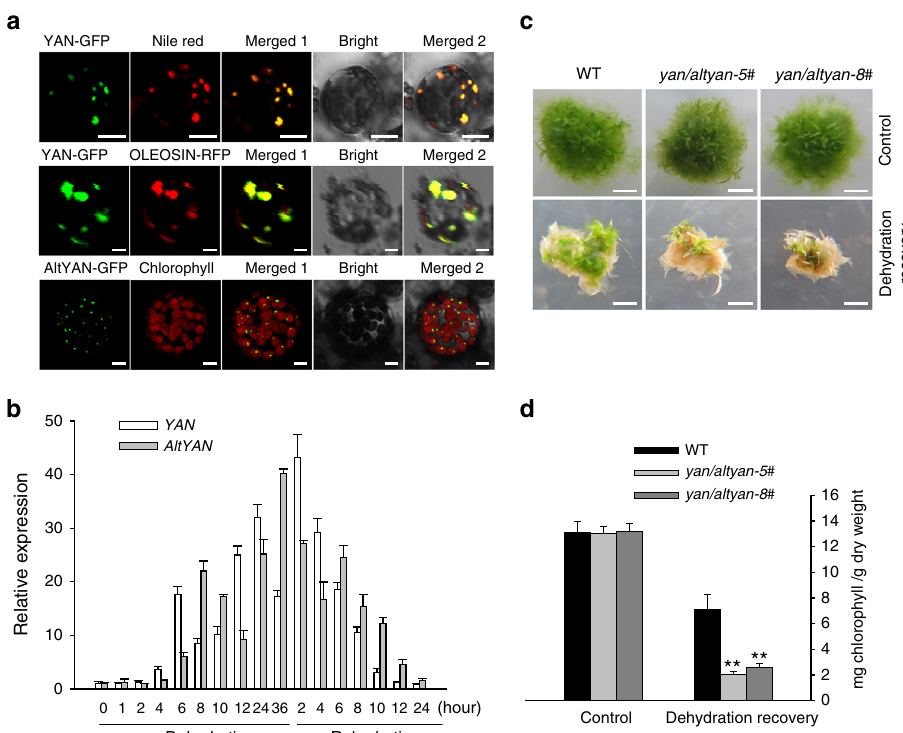
Fig. 2 Protein subcellular localization and recovery of P. patens clones after dehydration treatments. a YAN is localized in oil bodies as indicated by the green fl uorescence of YAN-GFP merged with Nile red and OLEOSIN-RFP (red), respectively. AltYAN-GFP is localized in chloroplasts as shown by the merged green fl uorescence of AltYAN-GFP with chlorophyll auto- fl uorescence (red). Scale bar = 4 μ m. b Expression pro fi le of YAN/AltYAN under dehydration and rehydration. Results represent means and standard deviations of three biological replicates for the wild-type plants. c Phenotypes of wild- type plants and yan/altyan mutants under control and dehydration treatments. Wild-type and yan/altyan plants were dehydrated for 20 h and transferred into sterile water for 1 h, and then transferred onto standard medium for recovery. Photos were taken after plants were recovered for 2 weeks. Scale bar = 2 mm. d Chlorophyll contents of wild-type and yan/altyan plants after 2 weeks of recovery. Results represent means and standard deviations of three biological replicates for the wild-type and two independent mutants. Double asterisks indicate a statistically signi fi cant difference compared with wild-type plants based on a two-tailed Student ’ s t test ( p < results indicated that both transcripts encoded proteins. According to the approximate locations of these proteins, we used mitochondria marker plasmid p35S:PpCOX11-RFP , peroxisome marker plasmid p35S:PpPEX11-RFP , Golgi marker plasmid p35S: PpCTL1-RFP , and oil body marker plasmid p35S:PpOLEOSIN- RFP to co-transfect the protoplast with p35S:YAN-GFP and p35S: AltYAN-GFP , respectively. As shown in Fig. 2a, the green fl uor- escence of YAN-GFP overlapped the red fl uorescence of oil body dye Nile red and oil body marker p35S:PpOLEOSIN-RFP , indi- cating that YAN is localized in oil bodies. The green fl uorescence of AltYAN-GFP, on the other hand, overlapped the red auto- fl uorescence of chloroplasts, indicating that AltYAN is localized in chloroplasts (Fig. 2a).